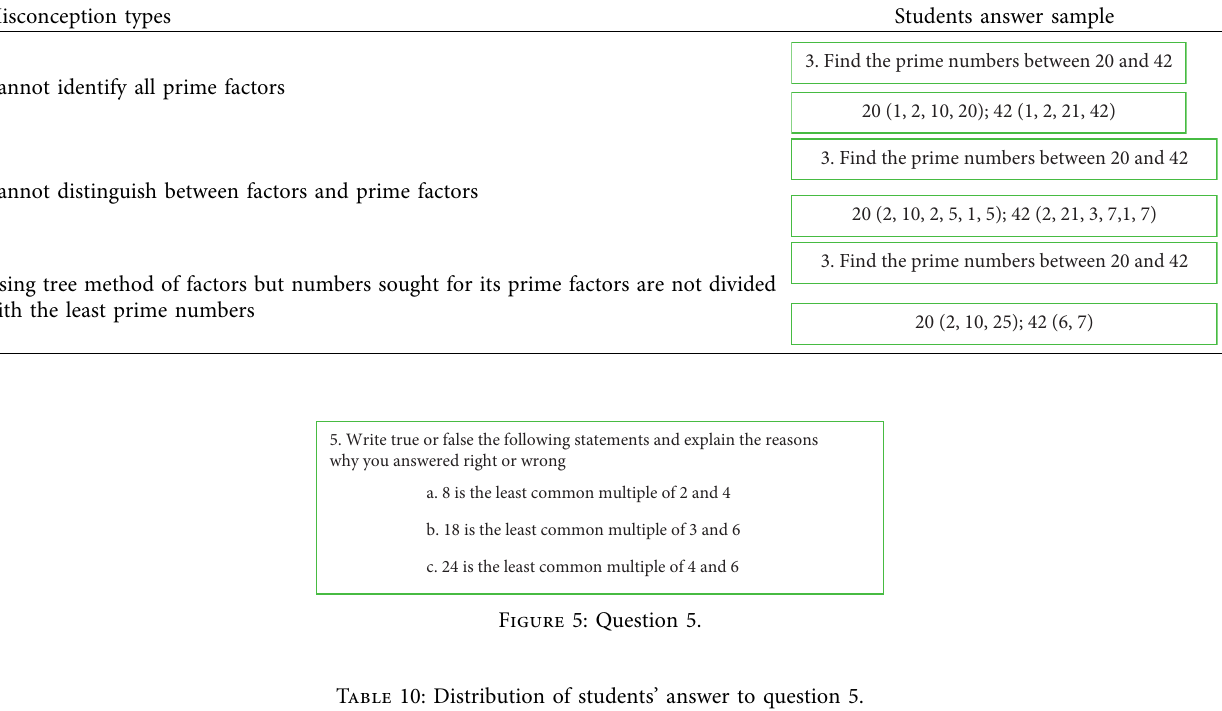
Table 9: Students misconception in question 4 and its answer category.